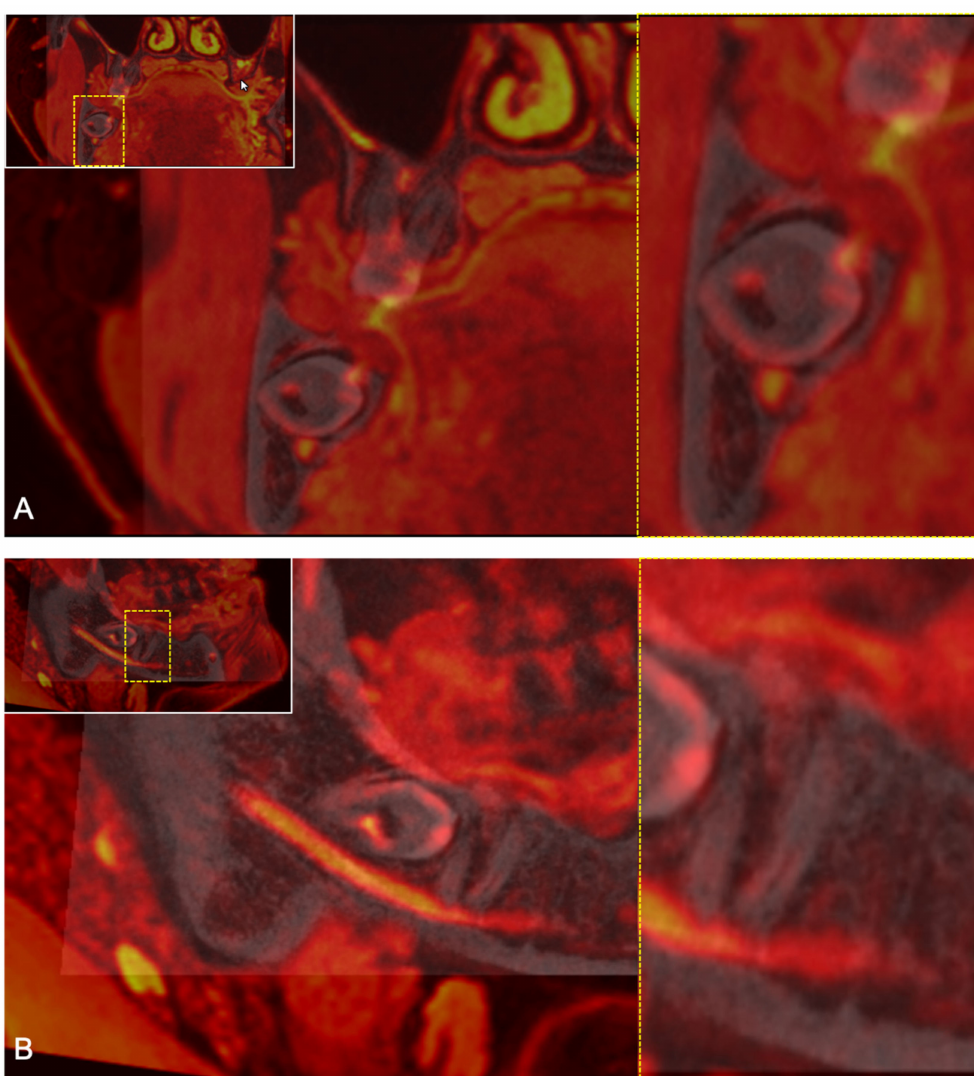
Figure 7. Fusion of a study participant’s 3D-DESS MRI (red) and CBCT (grey), demonstrating the good imaging quality. For orientation, the dotted rectangles in the corner show the enlarged area. ( A ) Coronal reconstruction showing the intraosseous position of the IAN (red, hyperintense signals) at the level of the third molar. ( B ) Sagittal reconstruction showing the intraosseous course of the IAN (red, hyperintense signals) at the level of the third and second